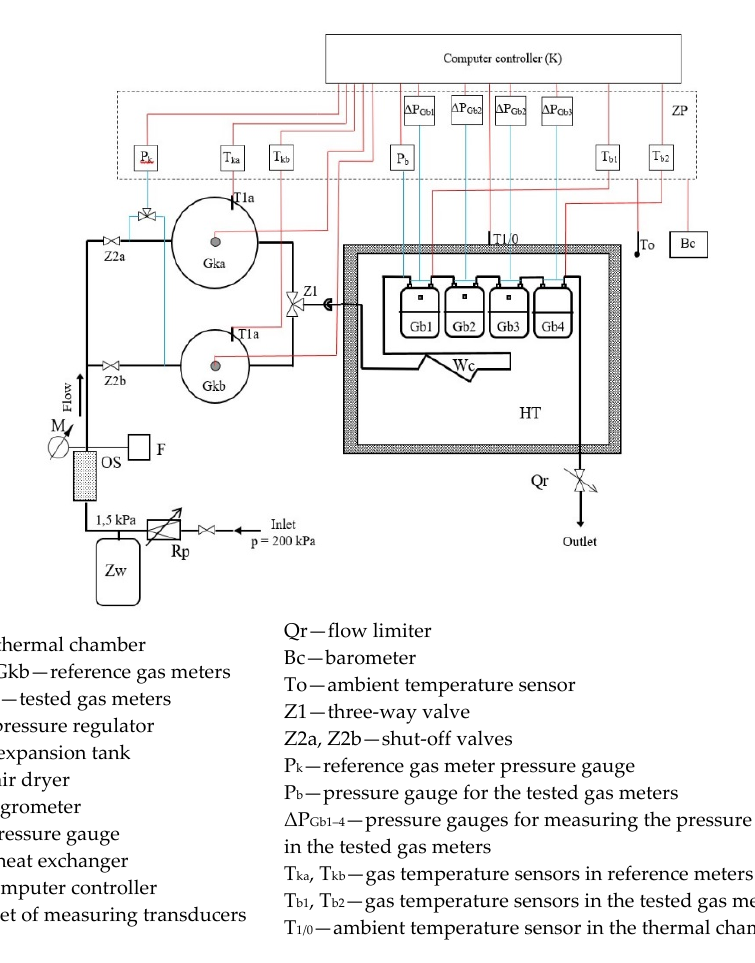
Figure 5. Diagram of the bench for testing the effect of ambient and gas temperature on the errors of indications of gas meters.